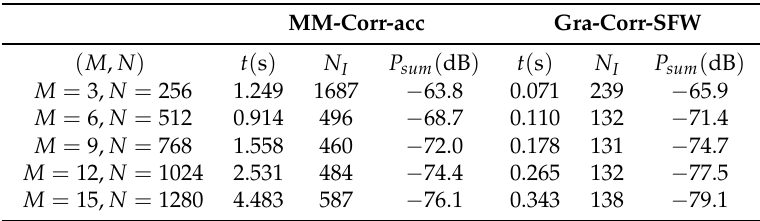
Table 3. The comparison of the performance parameters between MM-Corr-acc and Gra-Corr-SFW.